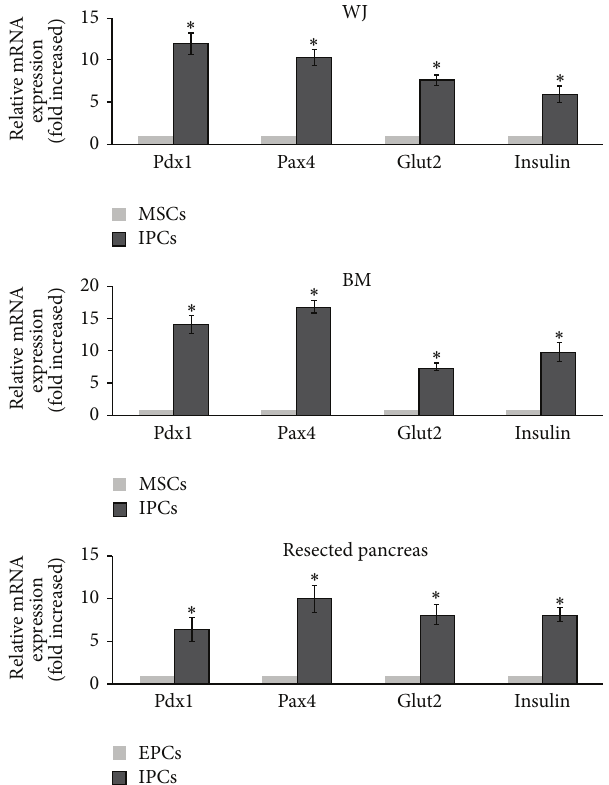
Figure 1: Real-time PCR analyses of three kinds of cell sources after differentiation to evaluate the expression of pancreatic 𝛽 -cell development-related and insulin production-related genes, including Pdx1, Pax4, Glut2, and Insulin. Results are the means ± SD for 6 experiments. ∗ : 𝑃 < 0.05 compared to nondifferentiated